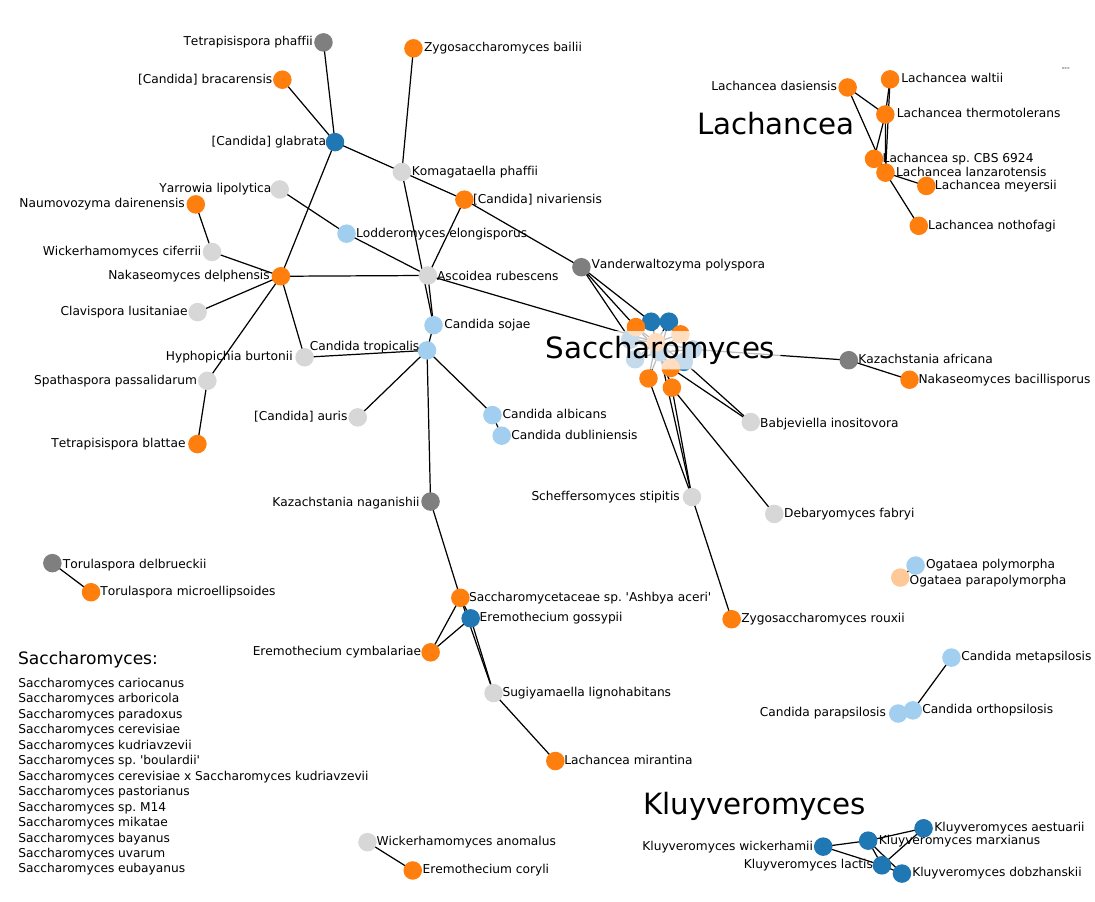
Figure 4. Summary of the BLAST -based survey of TER genes. Blue nodes show TERs described in the literature, orange nodes represent TERs that we identified, and grey nodes are additional candidates for which we could not validate characteristic features. TERs outside the Saccharomycetaceae group are presented in light colors. The length of the edges are weighted by the inverse of the length of the BLAST hit. Note that distances in drawing between nodes not connected by an edge are not indicative of their evolutionary